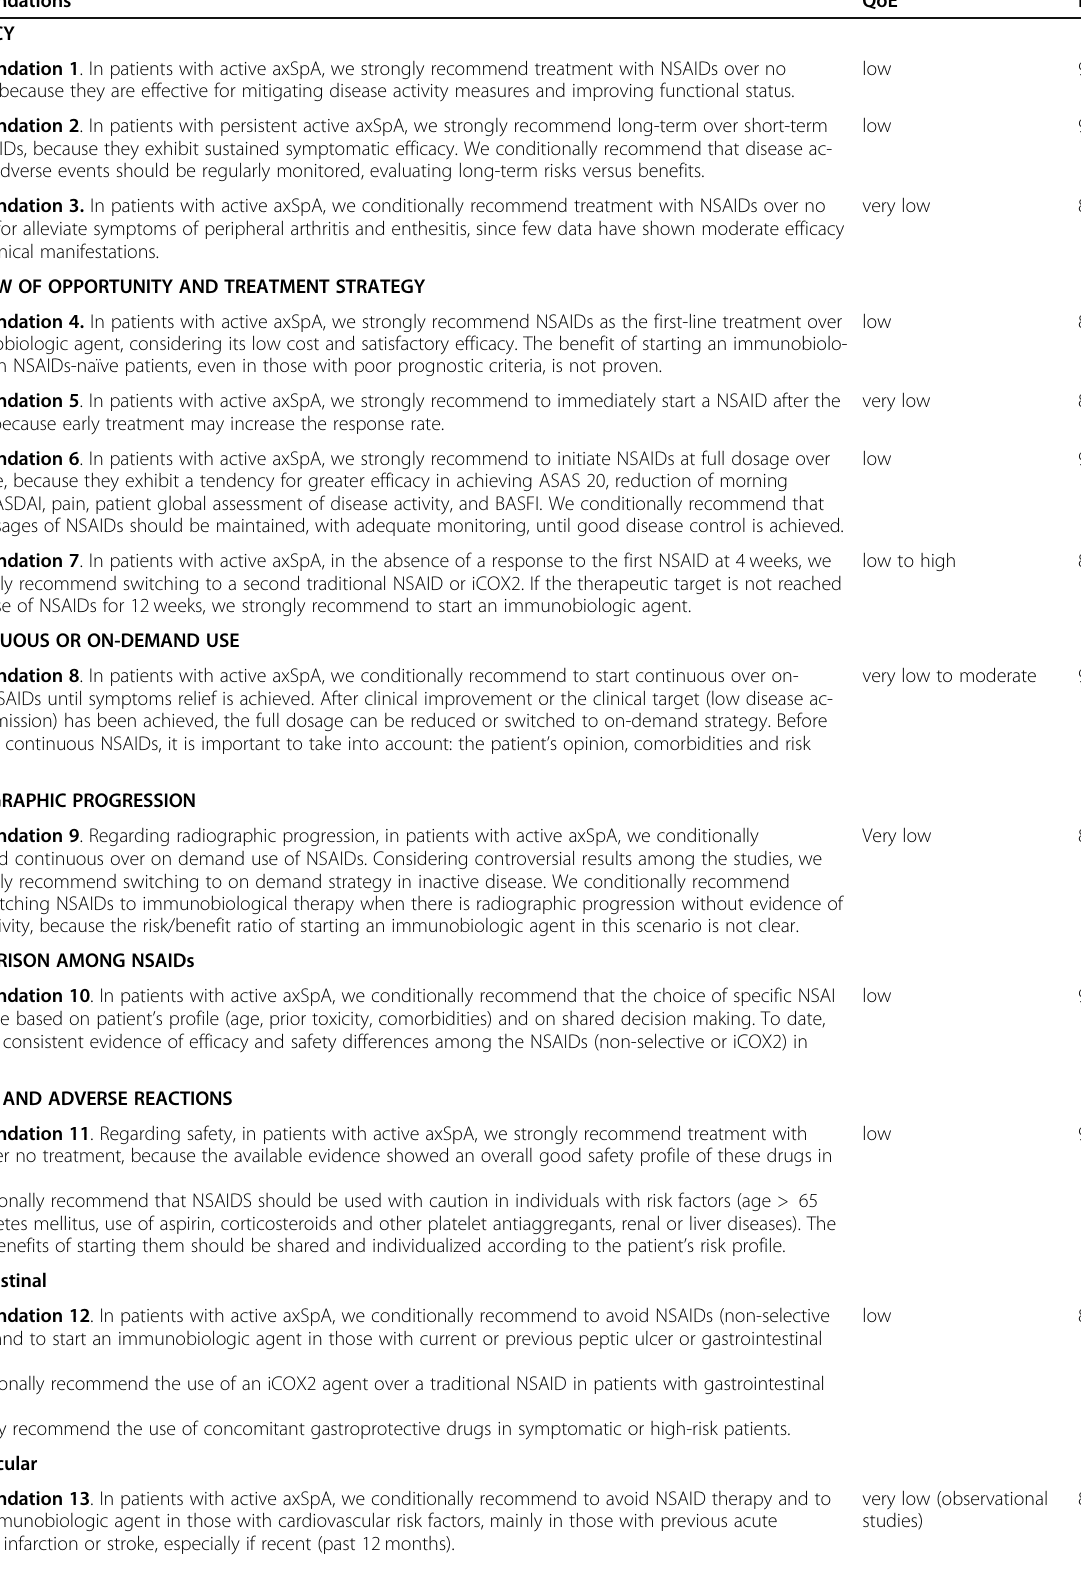
Table 1 Brazilian recommendations for the use of nonsteroidal anti-inflammatory drugs in patients with axial spondyloarthritis